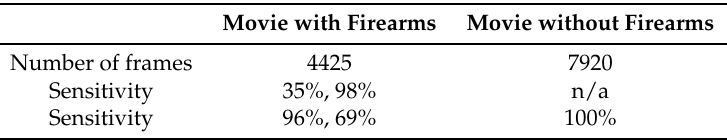
Table 6. Firearm detection: results for the algorithm with a reduced number of false